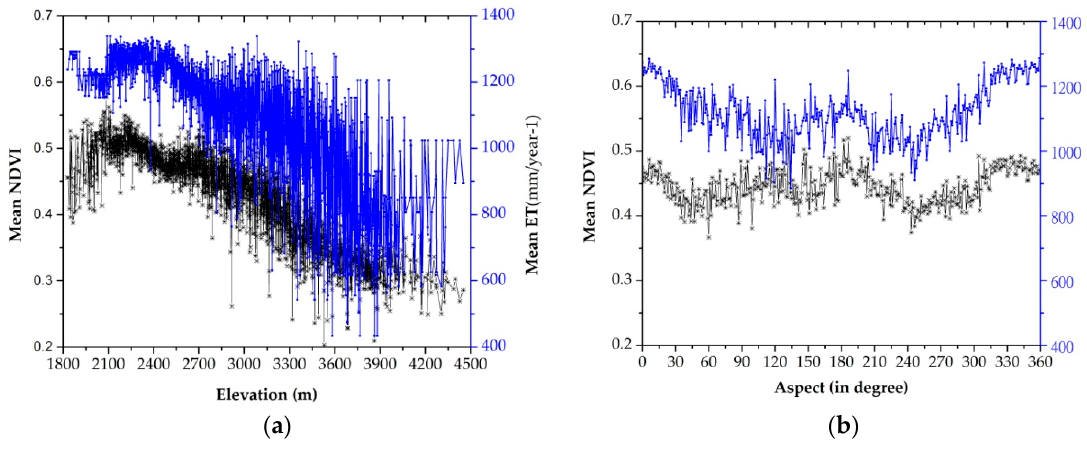
Figure 9. Scatter plot (spline connected) showing the change of NDVI with the mean annual ET per elevation ( a ) and per aspect ( b ).